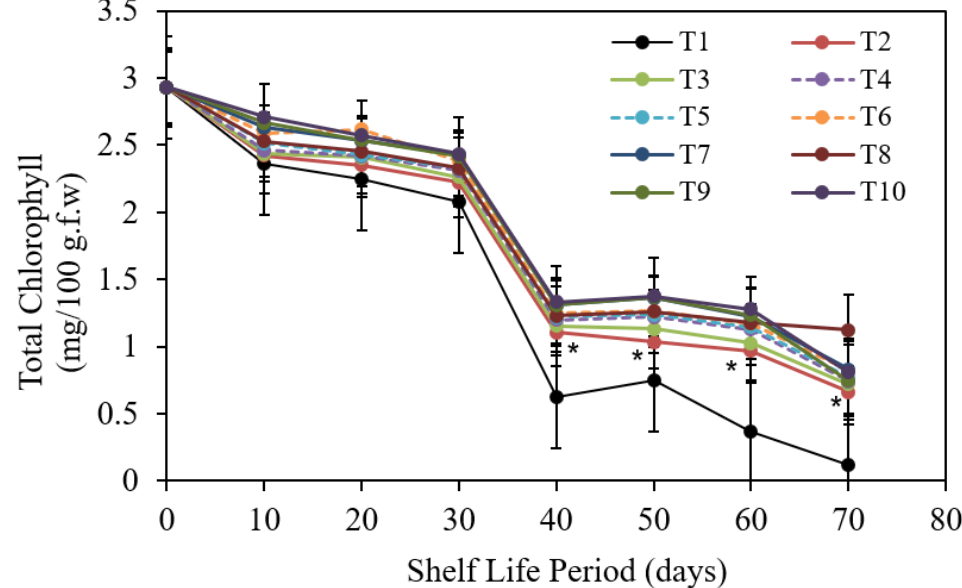
Figure 14. The impact of pre-harvest chitosan, chitosan nanoparticle, and CaCl 2 foliar spray treatments on total chlorophyll content of Barhi date fruits under cold storing for 70 d. Note that * sign denotes the significant differences between the control and edible coatings treatments, and T1, T2, T3, T4, T5, T6, T7, T8, T9, T10 are water (control), 1 g/L chitosan, 2 g/L chitosan, 3 g/L chitosan, 1 g/L chitosan nanoparticles, 2 g/L chitosan nanoparticles, and 3 g/L chitosan nanoparticles treatments, respectively.